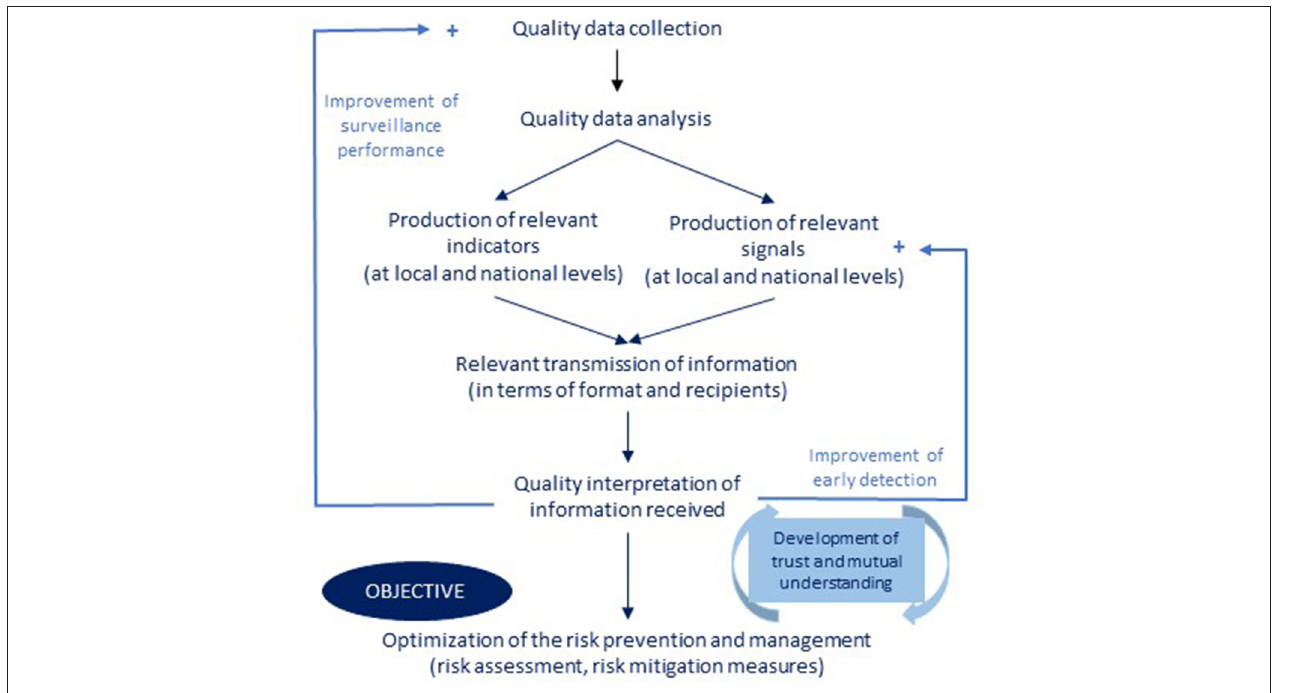
FIGURE 9 | The representation of the desired surveillance system for Salmonella in France.